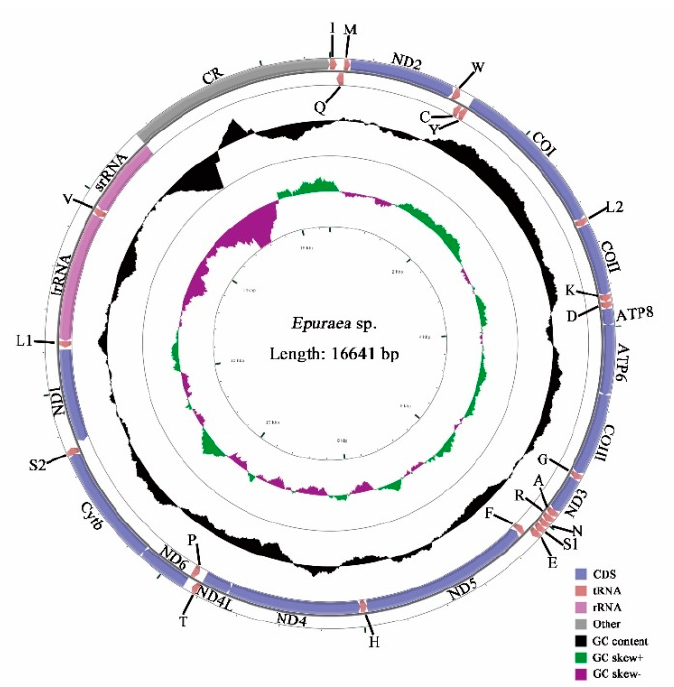
Figure 2. Mitochondrial map of Epuraea sp. Table 4. Mitogenomic organization of X. variegatus and Epuraea Table 2 . Nucleotide composition of mitogenomes of X. variegatus and Epuraea sp.